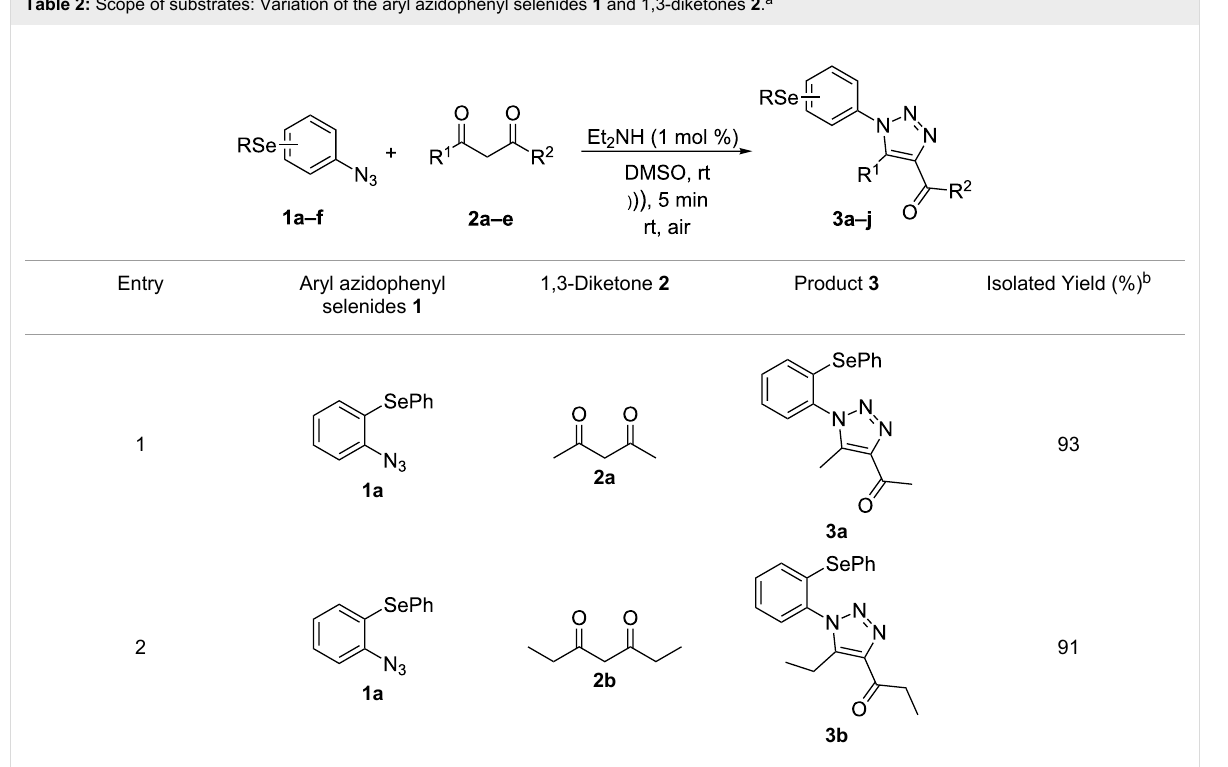
Table 2: Scope of substrates: Variation of the aryl azidophenyl selenides 1 and 1,3-diketones 2 .